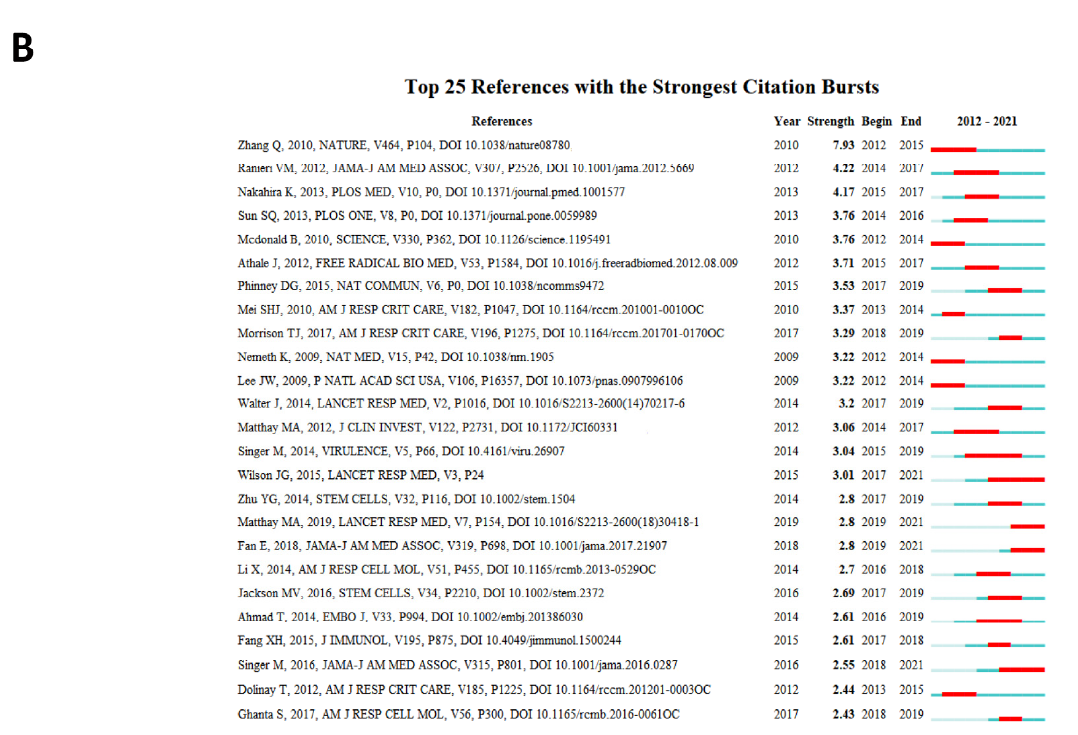
Figure 8. ( A ) Papers with the strongest citation bursts in original articles on the mitochondria in ALI between 2012 and 2021. Note: Each node represents a cited reference, and the red circle outside the node means that the reference has a strong citation burst. The links between nodes reflect the strength of the co-citation. The different colors represent the publication year of the paper, with purple being the earliest and yellow being the latest. ( B ) The top 25 references with the strongest citation